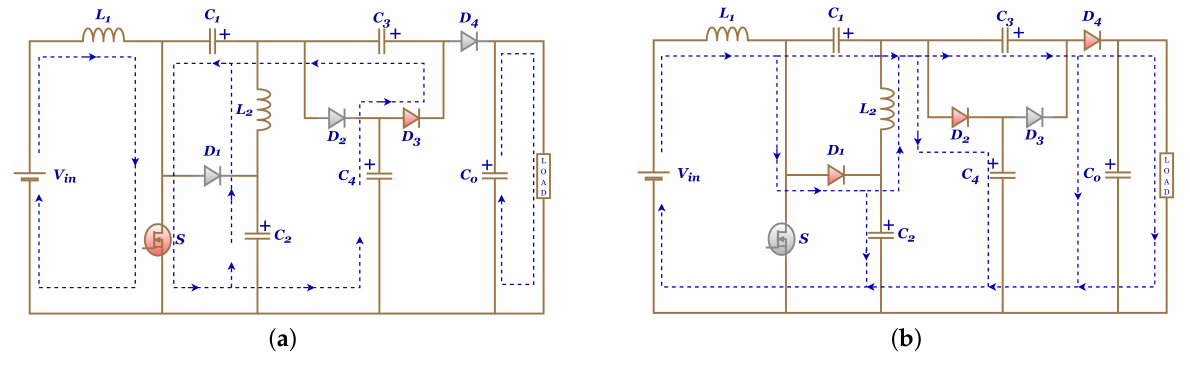
Figure 23. 2nd M-SEPIC operations ( a ) S closed ( b ) S open.